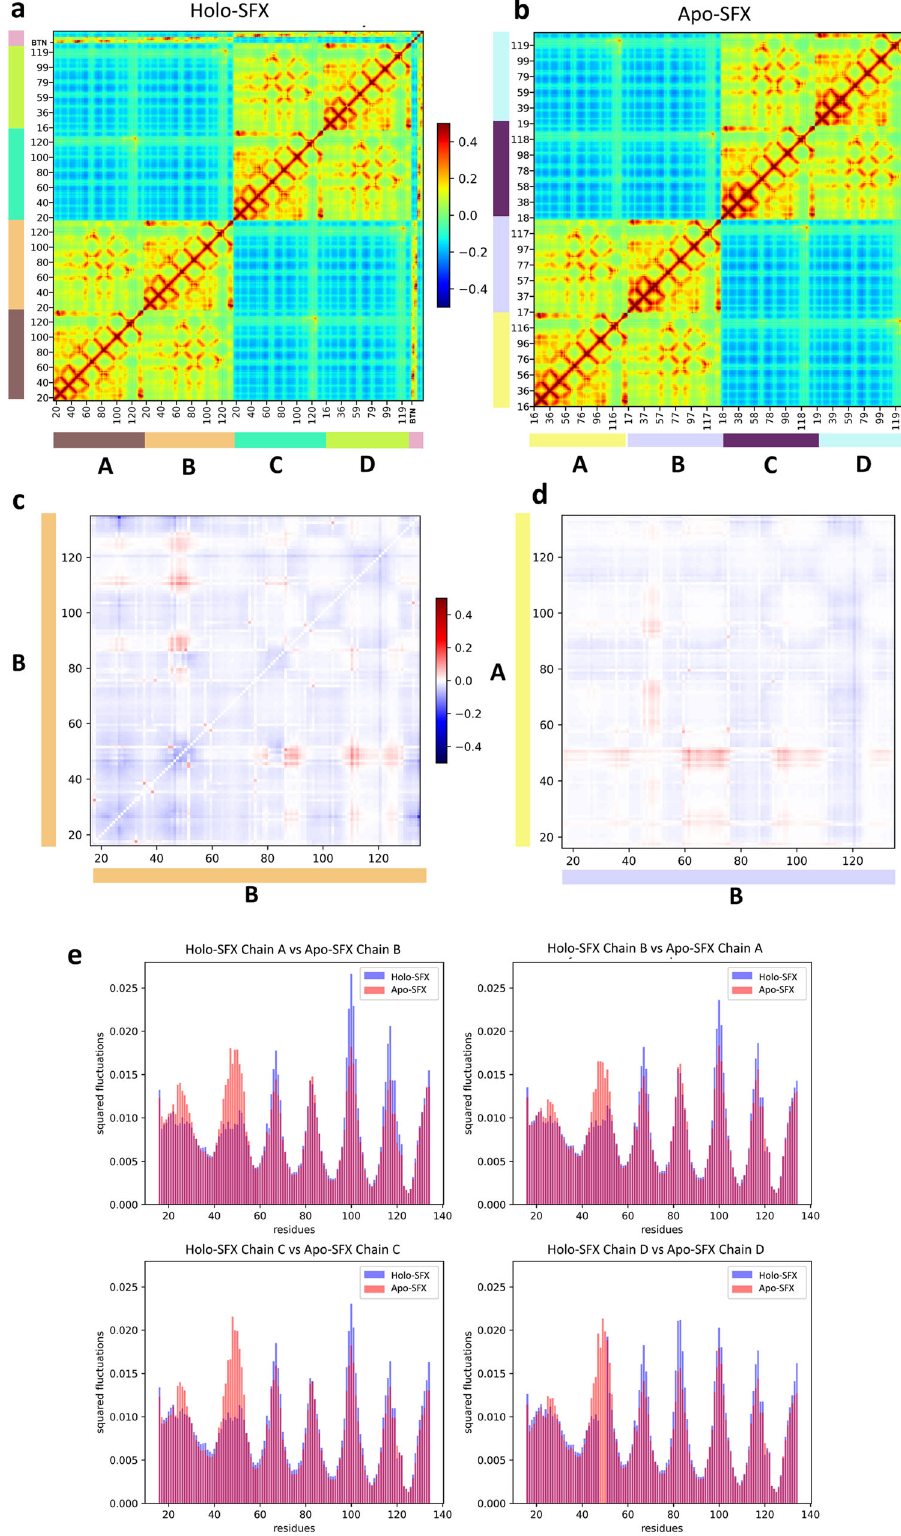
Fig. 8 Gaussian Network Model (GNM) analysis results for Apo-SFX and Holo-SFX (PDB ID: 5JD2) structures of streptavidin with selenobiotin. a Cross-correlation heat-map from overall GNM modes for Holo-SFX structure. Selenobiotin was indicated with “ BTN ” in the fi gure. b Apo-SFX structure GNM analysis heat-map results from overall modes. Highly correlated residue motion was represented with red and anti-correlated residue motions with blue color in a , b . c The differences between intrachain cross-correlations of chain B for Holo-SFX structure over Apo-SFX structure results. d Differences in the interchain cross-correlations of Holo-SFX structure over Apo-SFX structure at cross-sections of chains A and B. Differences in correlations are represented with blue color for decrease and red for increase. e Mean squared fl uctuations of each chain of Holo-SFX structure and Apo-SFX structure was calculated from the 10 slowest mode from GNM